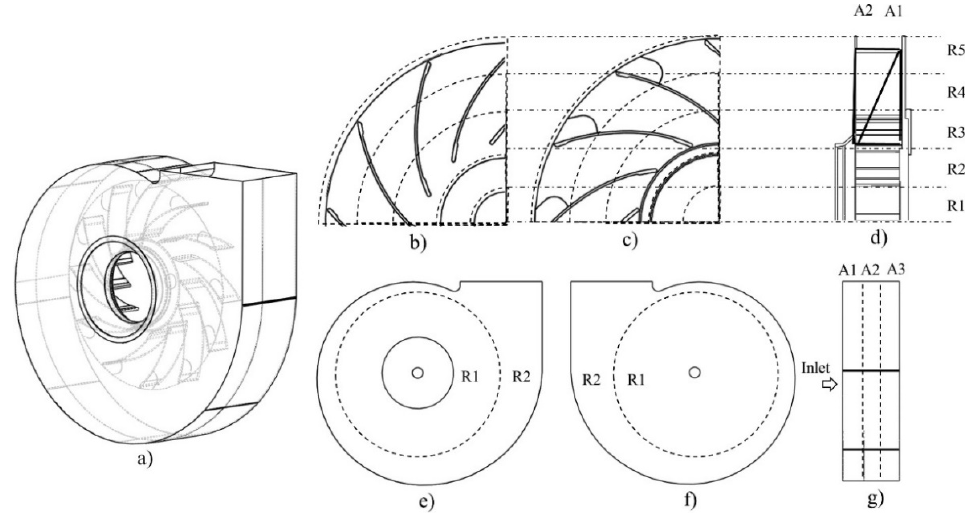
Figure 4. The strategy of fan surface patching: ( a ) fan model, ( b ) hub, ( c ) shroud, ( d ) rotor, ( e ) volute front side, ( f ) volute back side, and ( g ) volute lateral side.